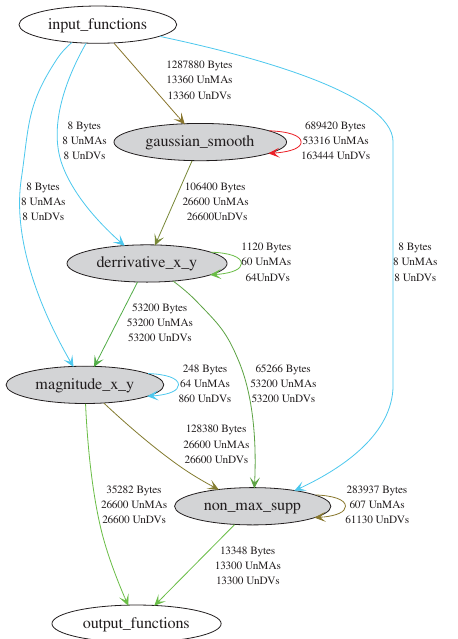
Figure 2. Data communication graph of the Canny edge detection application